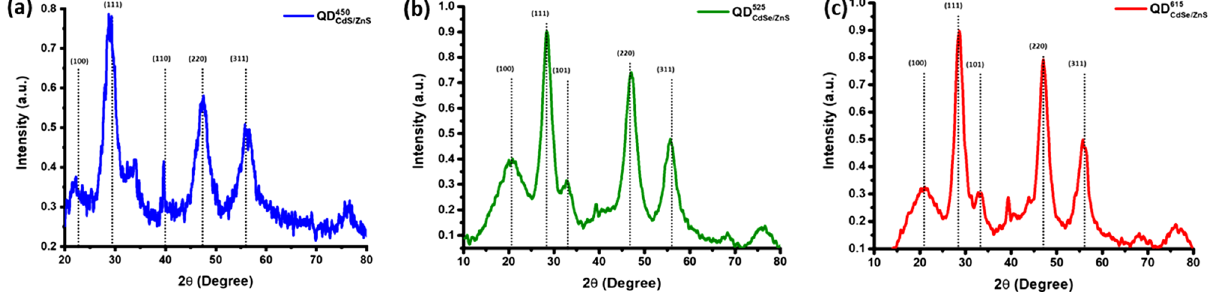
450 QD 525 CdS / ZnS ( b ) CdSe / ZnS ( c )